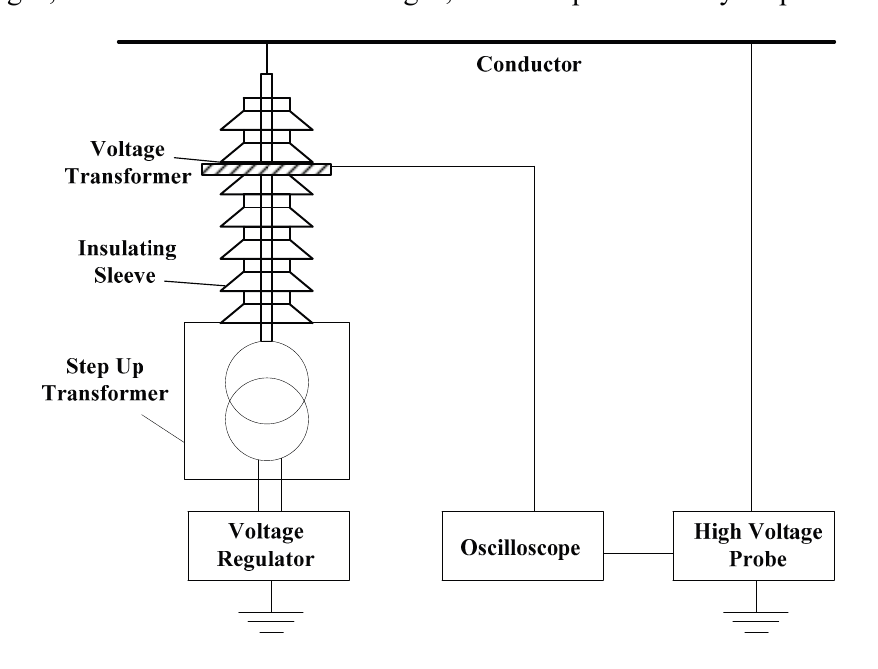
Figure 18. Experiment platform